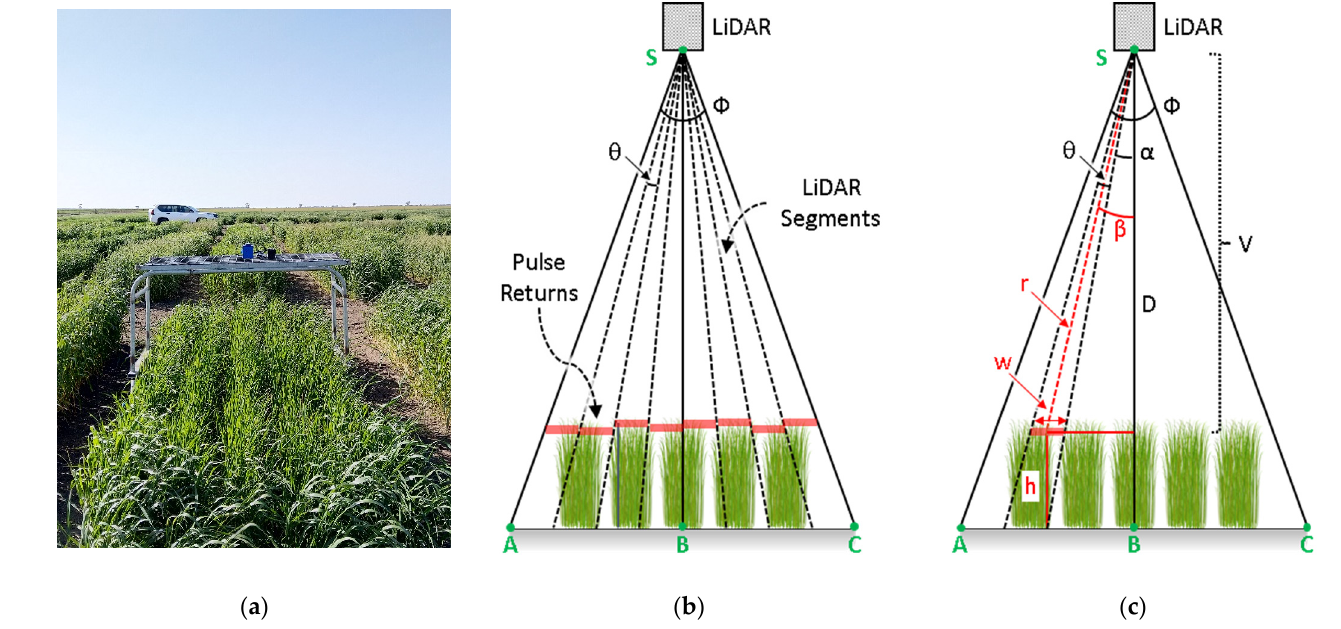
Figure 5. Scanning geometry of the CropBioMass (CBM) sensor with respect to the plots. ( a ) A frontal view of the push-type mobile vehicle with the CBM mounted on it, ( b ) the geometries of each of the eight individual detectors that were stacked inside the CBM sensor with the respective field-of-views (FoVs), and ( c ) trigonometric labeling of the scanning geometry for deriving the height using measure LiDAR ranges.